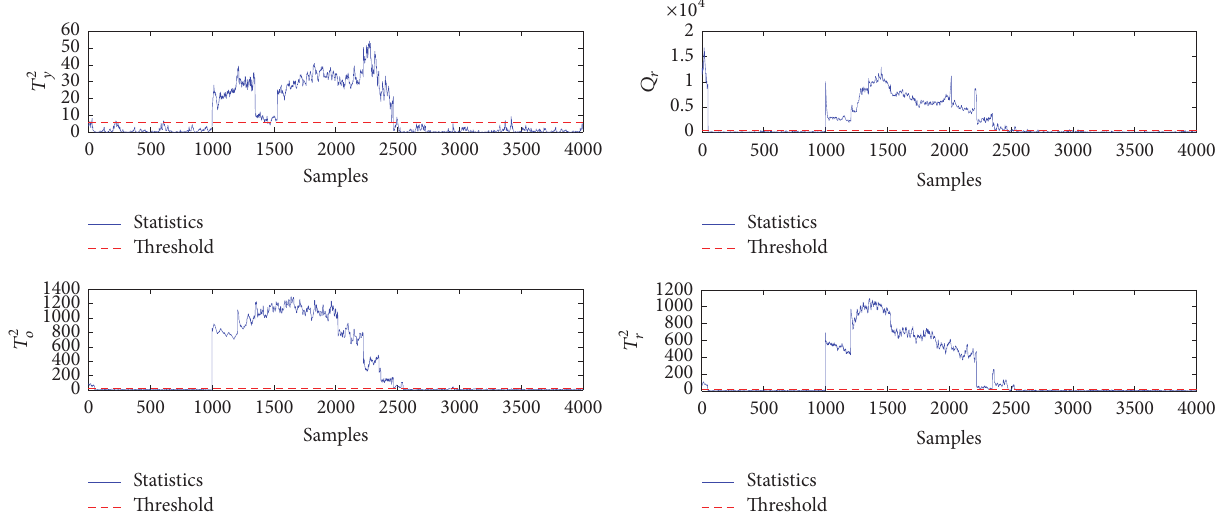
Figure 9: Detection result of fault 3.